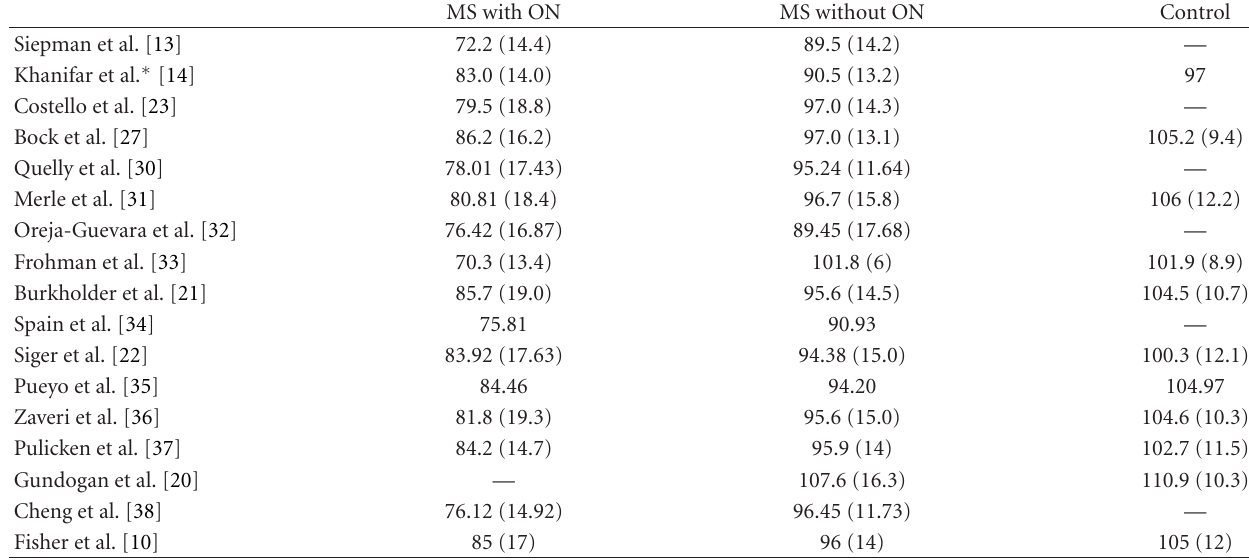
Table 2: Comparison of RNFL thickness ( µ m) between both eyes of patients diagnosed of multiple sclerosis who have su ff ered unilateral optic neuritis and healthy control